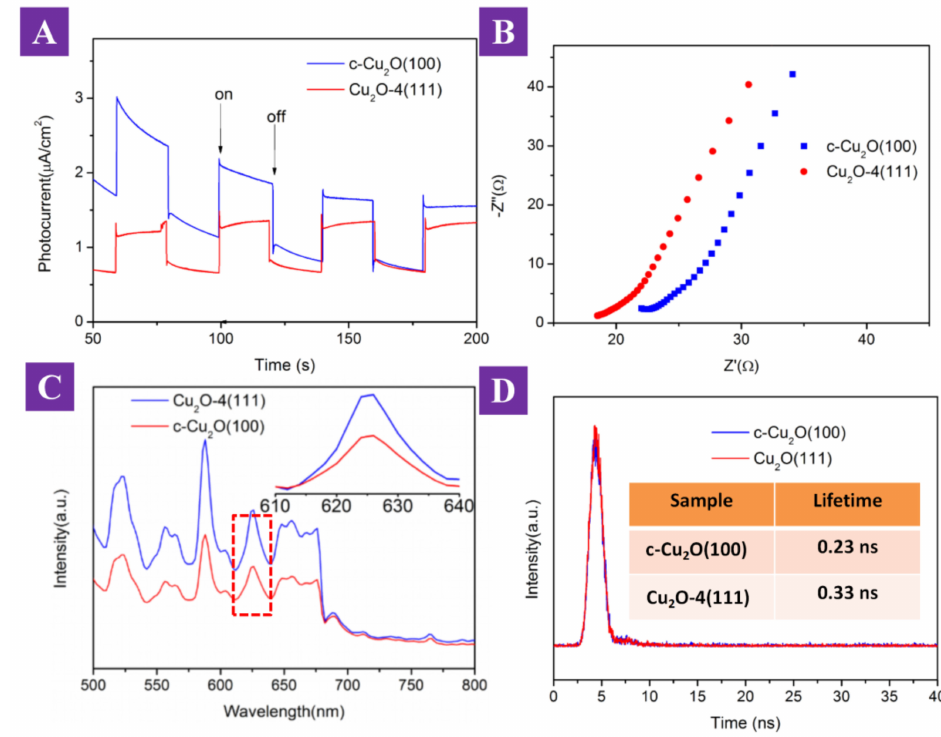
Figure 9. ( A ) Photocurrent response, ( B ) electrochemical impedance spectra, ( C ) PL spectra, and ( D ) TRPL decay curves of c-Cu 2 O(100) and Cu 2